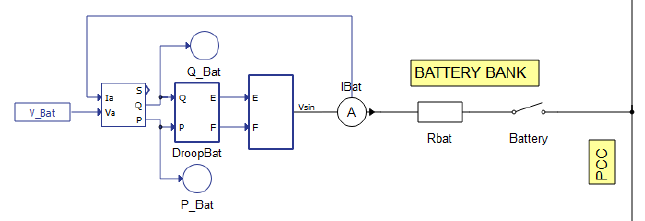
Figure 18. Battery bank experiment